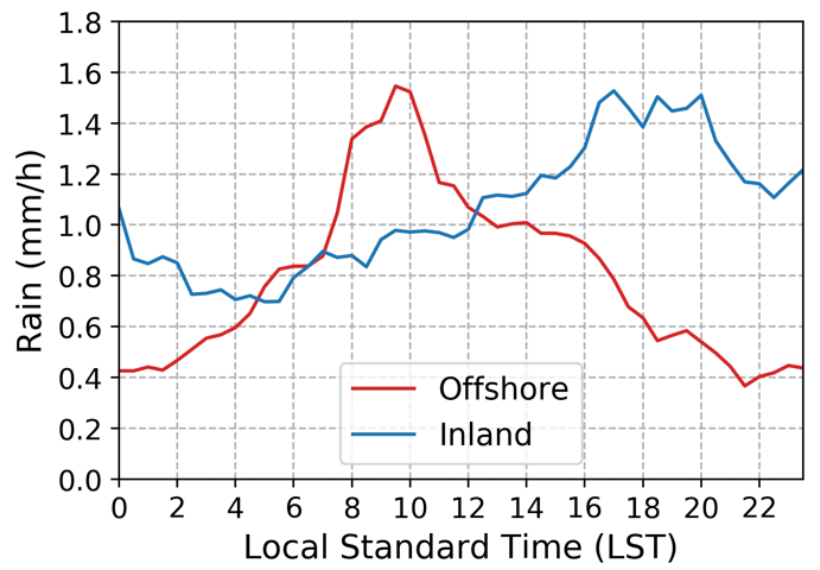
Figure 2. Three-hourly mean rainfall evolution (shown on the map) based on IMERG data. Days were selected from June 2017. The region highlighted with a black box is the SCCA, the area of focus in this study.